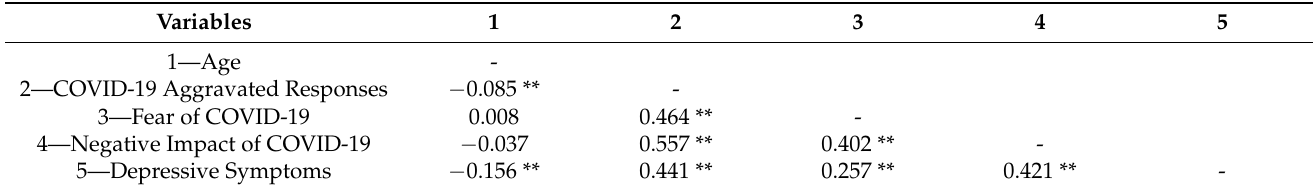
Table 8. Correlation Matrix.